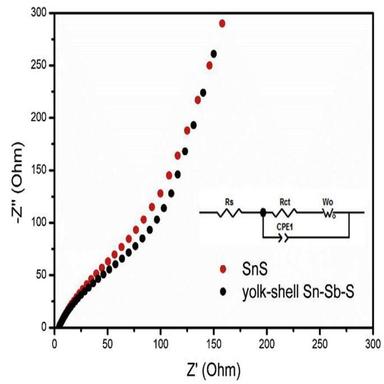
Nyquist plots of the electrochemical impedance spectra of yolk-shell Sn-Sb-S electrode and single-phased SnS electrode.